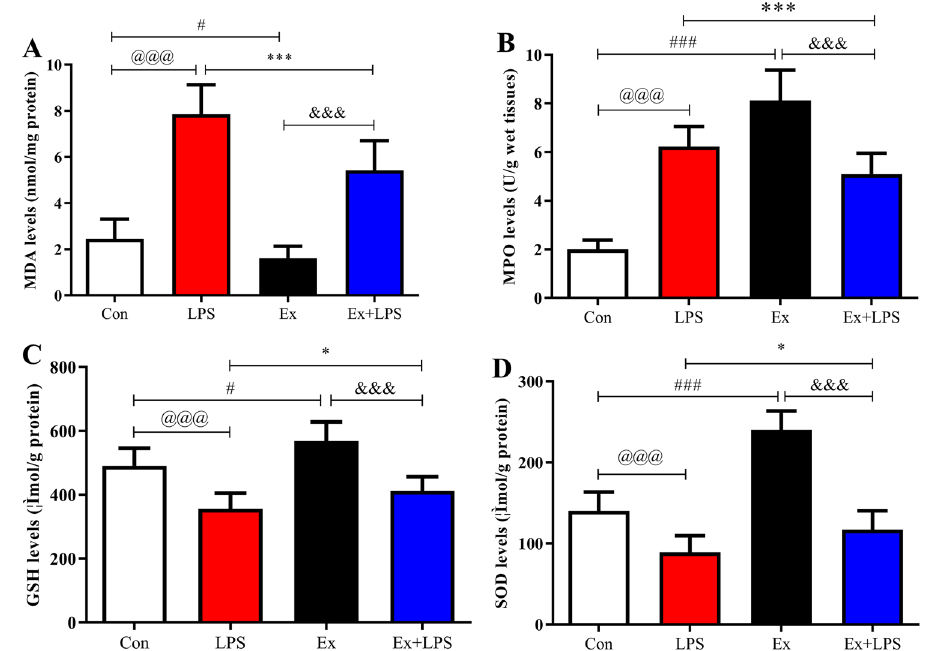
Figure 8. Detection of oxidative stress injury in lung tissue. The levels of MDA ( A ), MPO ( B ), GSH ( C ), and SOD ( D ) were detected. @ P < 0.05, Con versus LPS groups; # P < 0.05, Con versus Ex groups; * P < 0.05, LPS versus Ex + LPS groups; & P < 0.05, Ex versus Ex + LPS groups. MDA malondialdehyde, MPO myeloperoxidase, GSH glutathione, SOD superoxide dismutase.